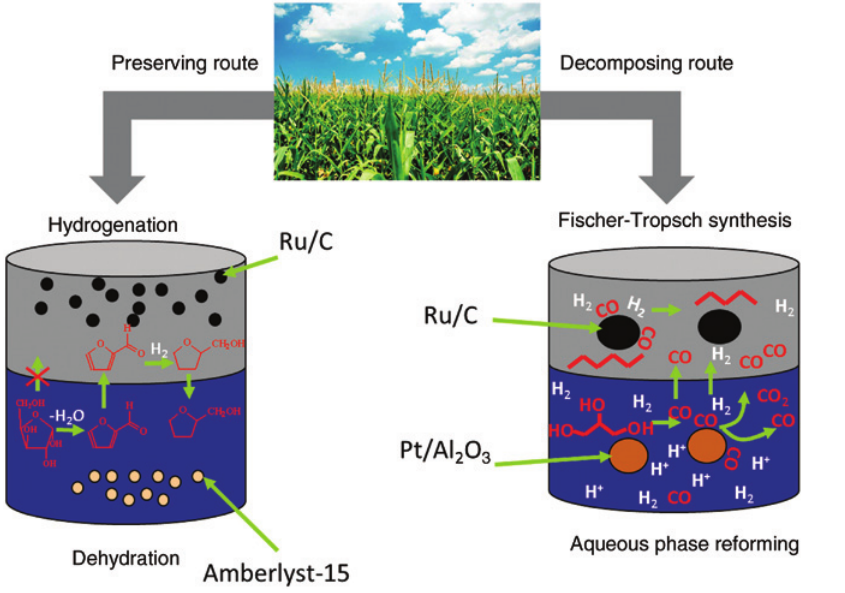
Figure 2: Scheme of reactive extraction for biomass valorization according to decomposing and preserving